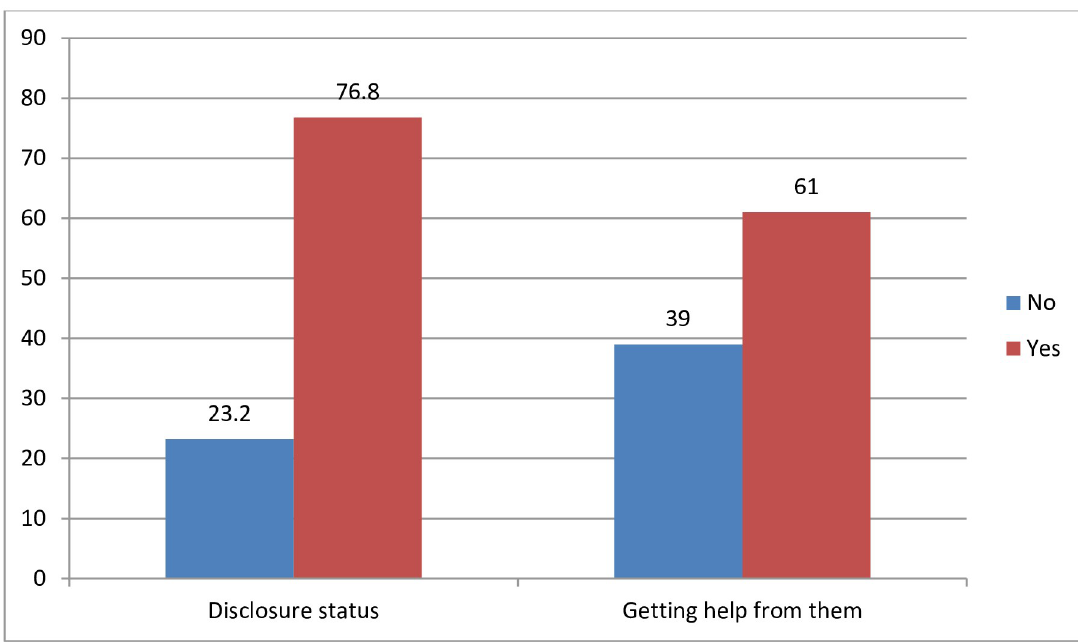
Fig 1. Percentage of disclosure of their status and getting support from them among pregnant & lactating mothers in selected governmental health facilities of Hawassa city, Southern Ethiopia, 2019/20 GC.